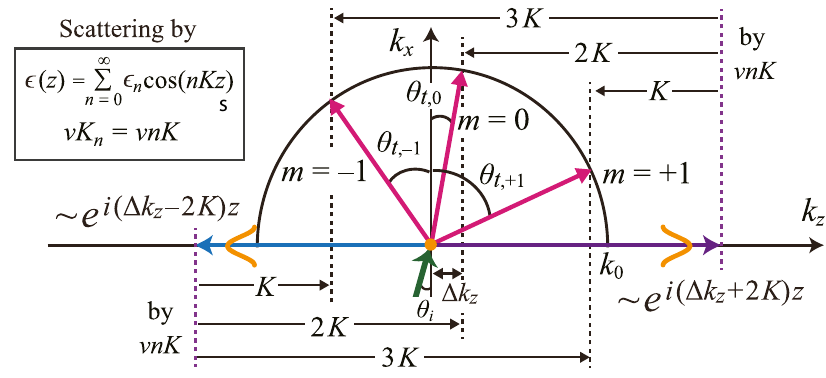
Figure 2: Resonant diffraction by Eq. (3) near the fourth stopband beyond the subwavelength